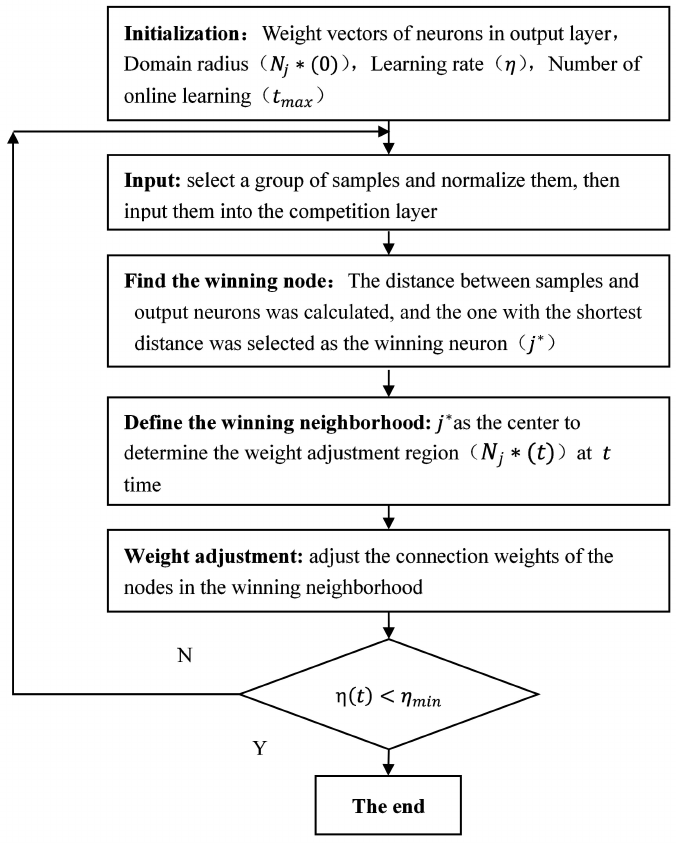
Figure 3. Clustering processes based on SOM network model.